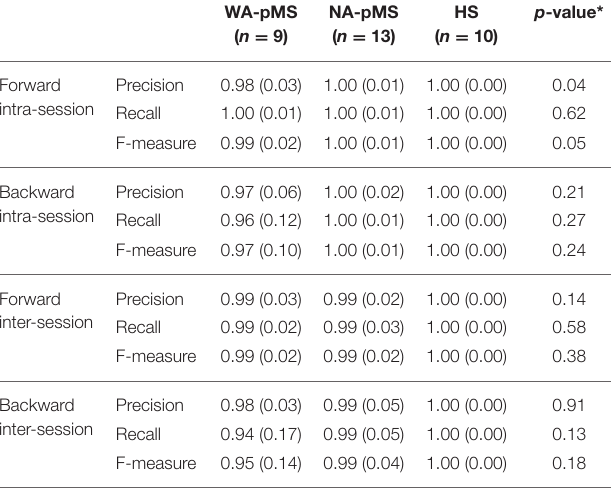
TABLE 5 | Performance (precision, recall, and F-measure) scores for the intra-group template-based detection (IGTD) algorithm.